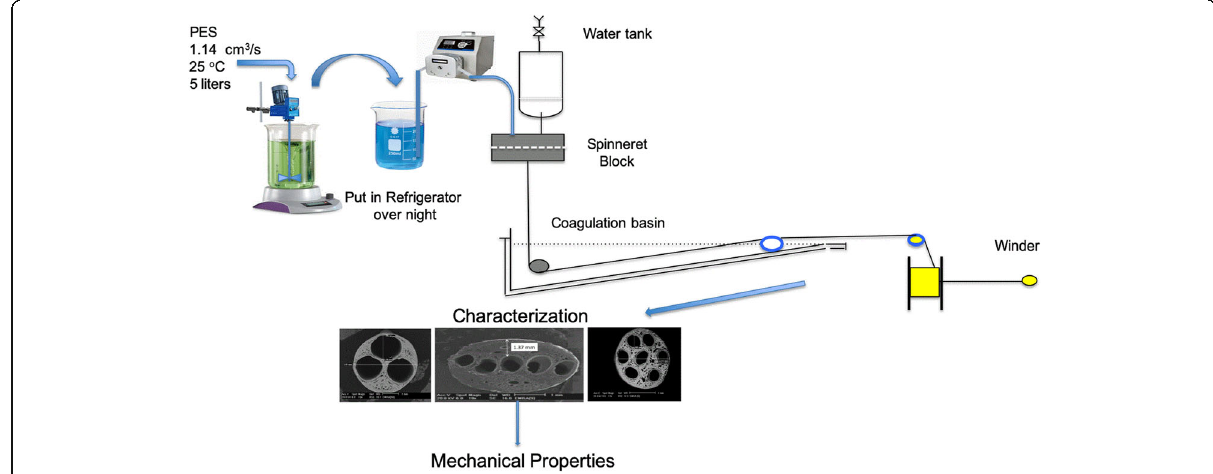
Fig. 5 Multi-bore hollow fiber (MBHF) membrane